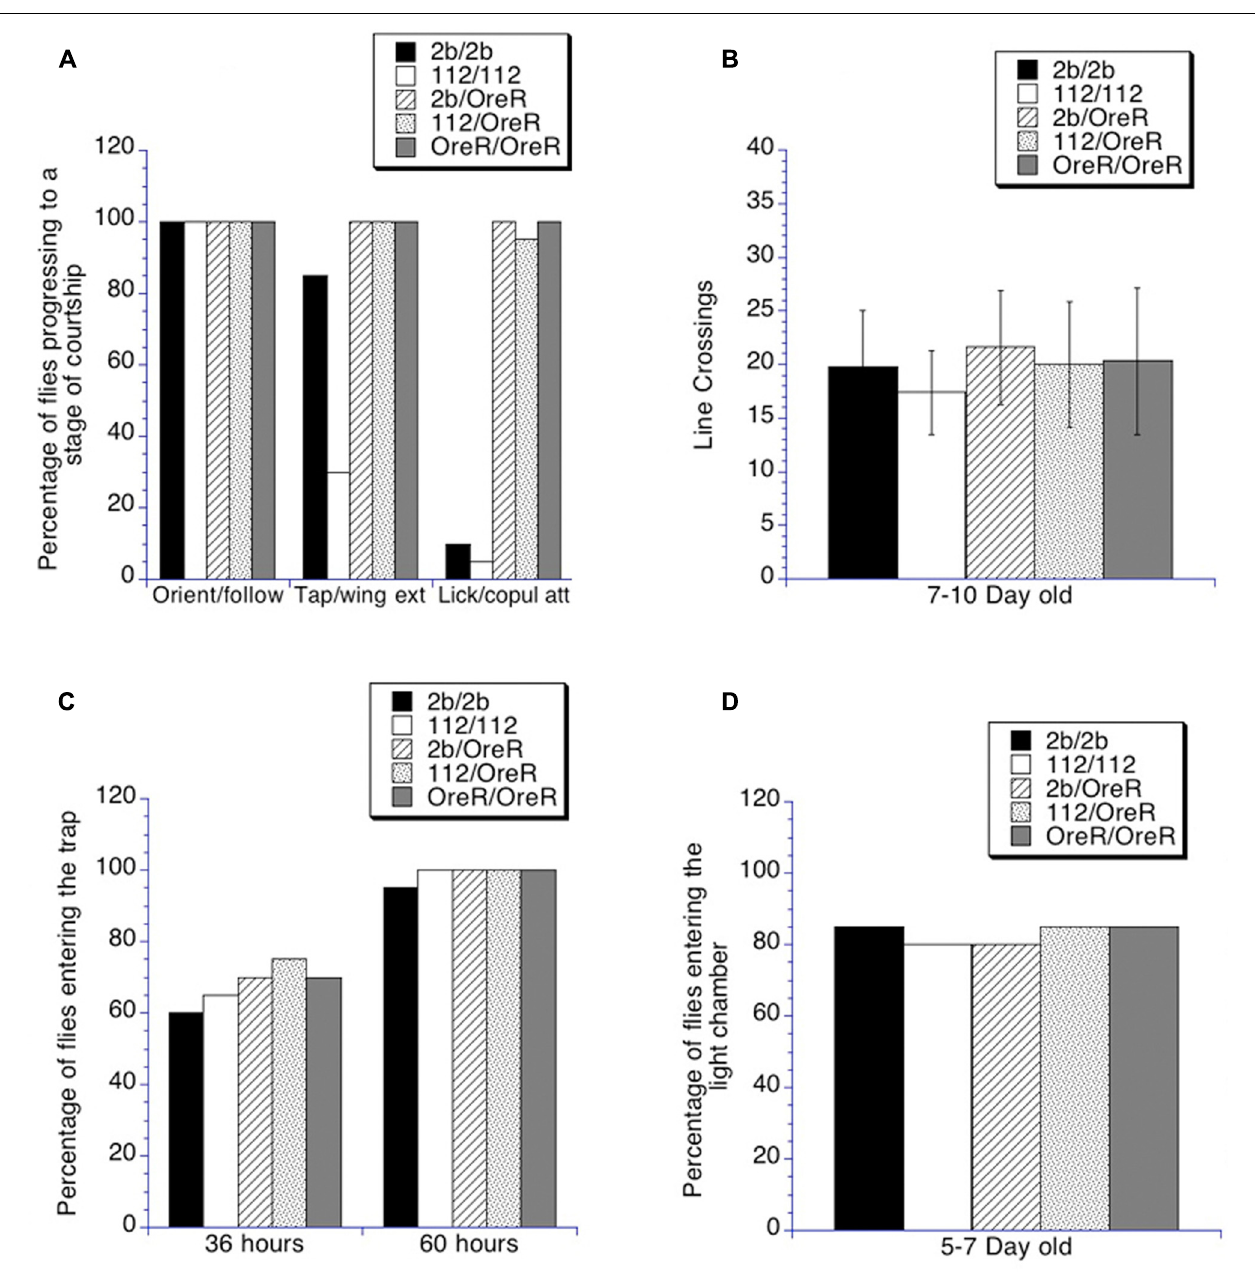
FIGURE 6 |Analysis of courtship quality, locomotor activity, olfaction, and visual acuity in DmGluRA mutants. (A–D) The Ns for all genotypes in all panels is > 19. Filled black bars indicate control homozygous males ( DmGluRA 2b precise excision, 2b/2b); Open bars indicate DmGluRA 112 homozygous mutant males (112/112); Striped bars indicate control heterozygous males ( DmGluRA 2b precise excision, 2b/OreR); Stippled bars indicate DmGluRA 112 heterozygous mutant males (112/OreR); Gray bars indicate OreR background males. (A) The quality of courtship that was performed by naïve males was further analyzed by binning the number of males that advanced to particular phases of courtship for each genotype that was shown in Figure 1 . All of the genotypes demonstrated that they could perform each phase of courtship.The DmGluRA 112 homozygous mutant males (112/112) did not demonstrated as much wing extension as the control males ( p < 0.05) and neither the homozygous control males ( DmGluRA